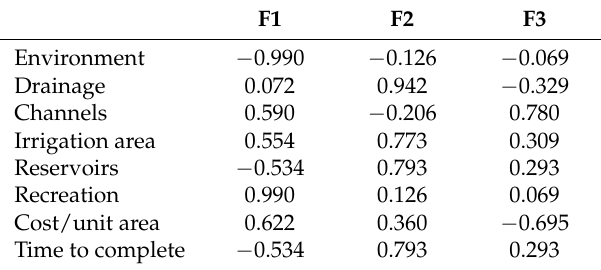
Table 9. Factor loadings according to PCA (Principal Component Analysis) for Scenario